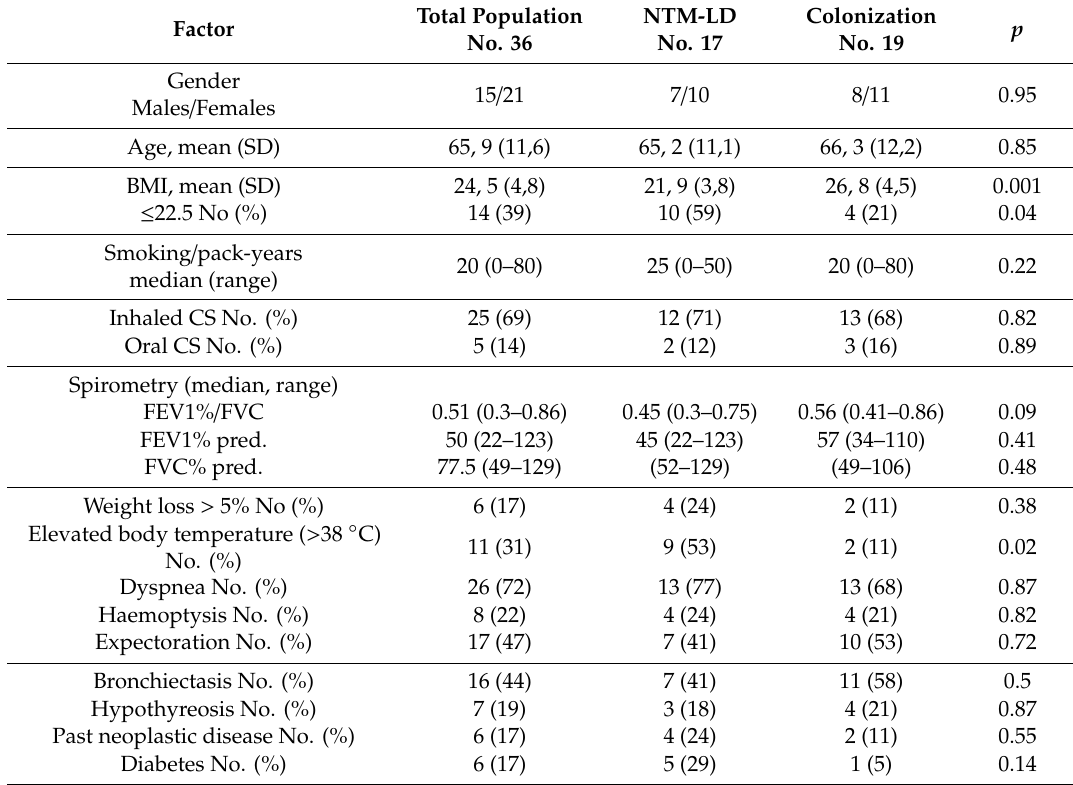
Table 1. Population characteristics in 36 patients with obstructive lung diseases and non-tuberculous mycobacteria (NTM) respiratory isolates.